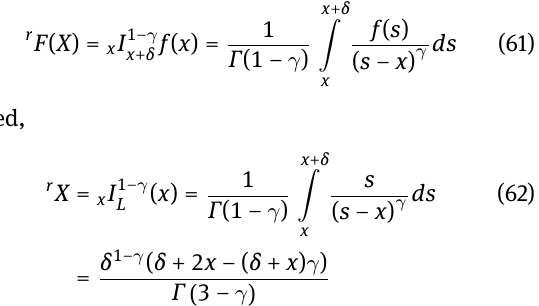
Figure 8: Distribution of body forces in the initial space with respect to the initial x